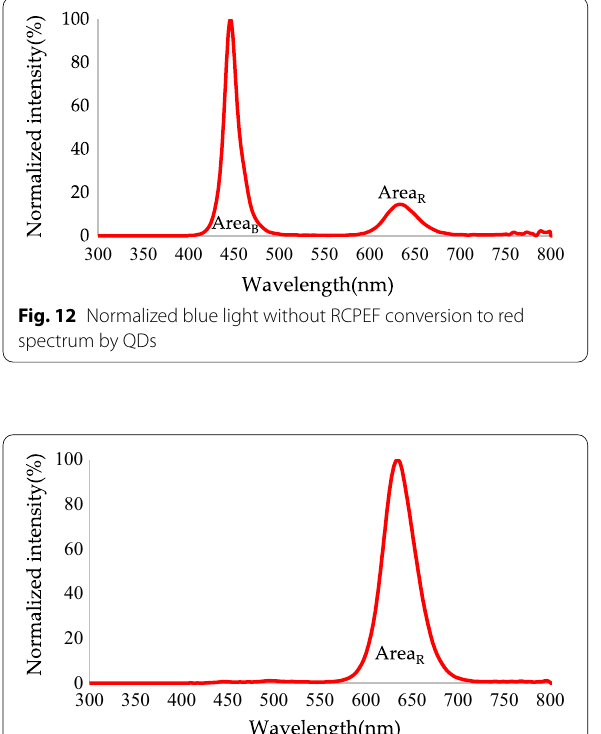
Fig. 13 Conversion of normalized blue light to red light by QDs after addition of